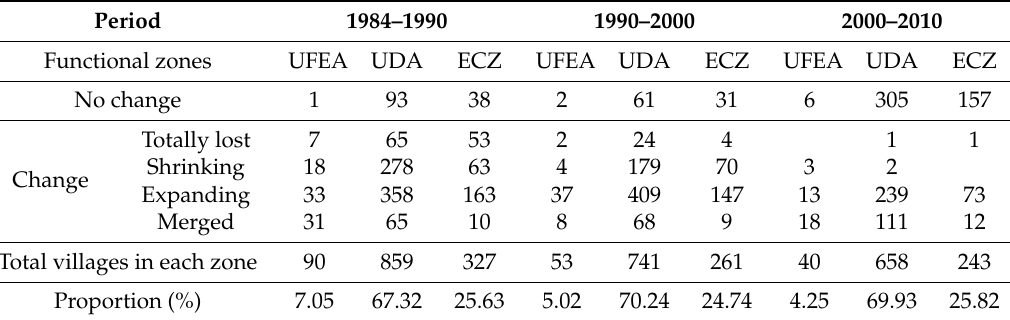
Table 6. The area changes of settlements in urban development areas.